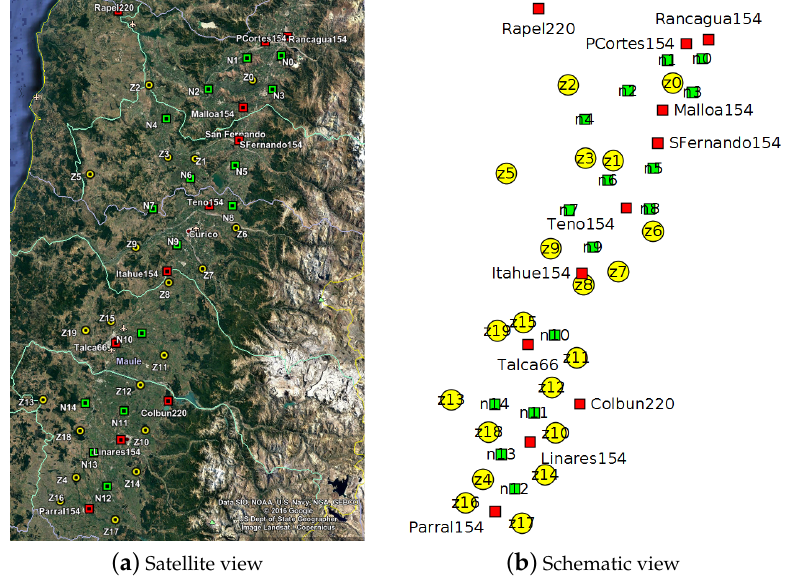
Figure 1. Graphical representation of the studied instance. We use squares to represent to substations; circles to represent generation zones ( V 1 ); green color indicates possible substations ( V 2 ); and red color for existing substations ( O